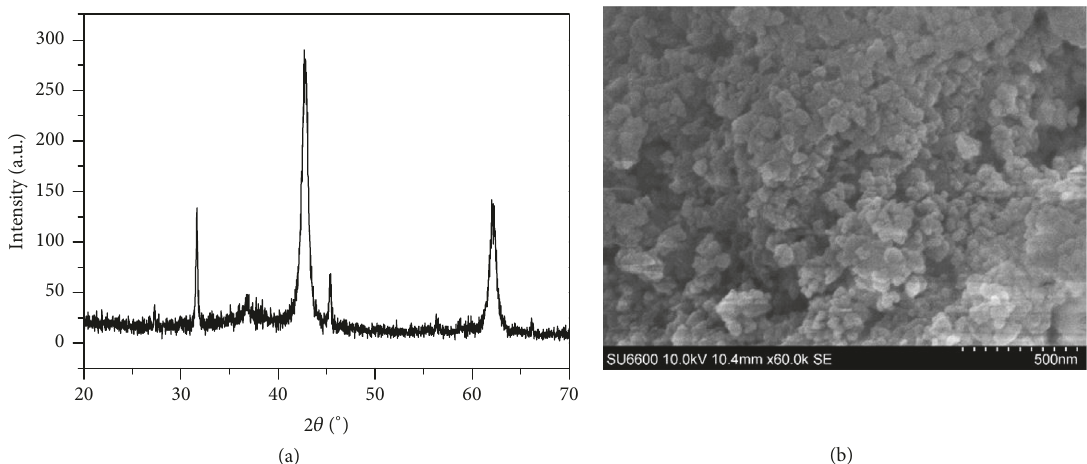
Figure 1: Structural analysis of MgO nanoparticles: (a) a graph of intensity versus angular position derived from XRD analysis and (b) a SEM image of MgO